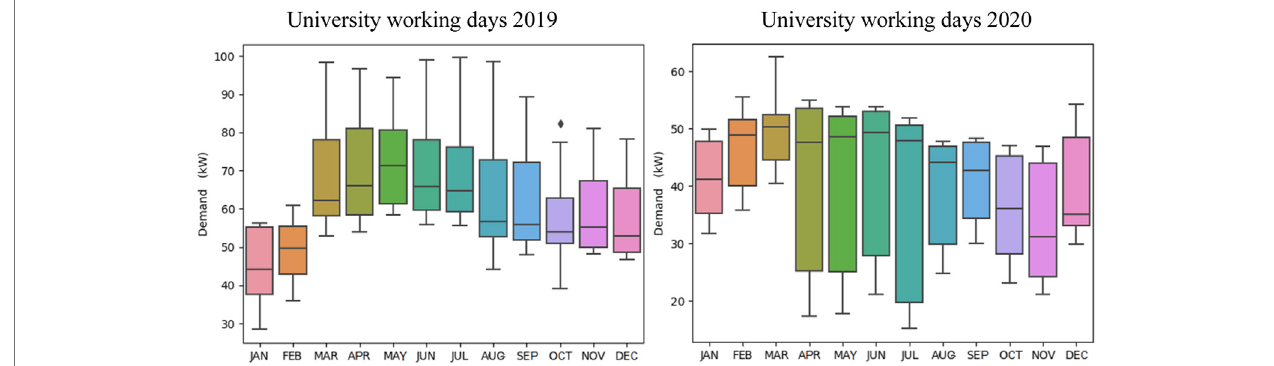
FIGURE 4 | Boxplot of the average hourly demand pro fi le for university working days.